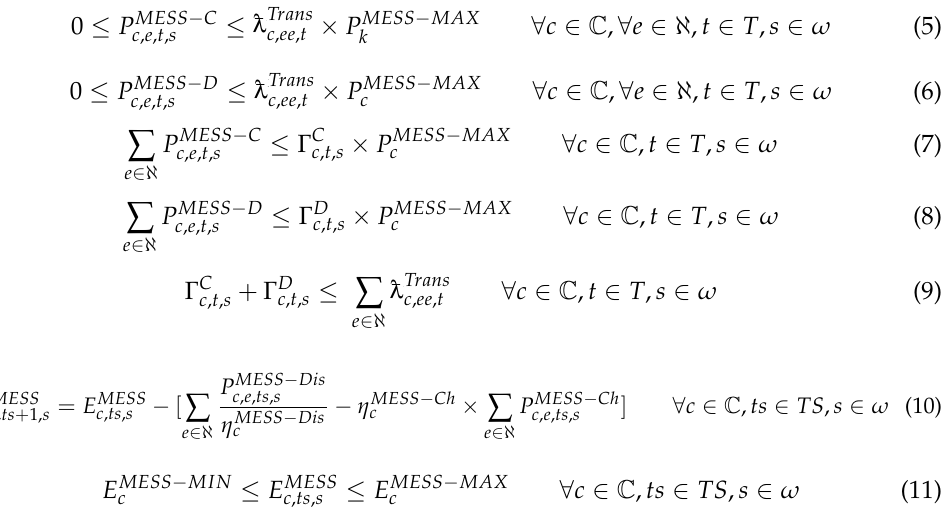
Figure 3. Time ‐ space network (TSN) concept. Equation (1) implies that MESS’s position can be located on any arc in time span ts. In (2), any MESS c at the end of the time span ( ts ) is in MG ( e , ts ) in the TSN, which indi ‐ cates that in the following time span ( ts + 1), MESS k should indeed be in one of the arcs that start from MG ( e , ts ). Specifically, Constraint (3) specifies that the outflow at each station equals the starting state of MESS k in the time span (1). Constraint (4) ensures that TESSs will never be able to perform an instantaneous round trip, meaning MESSs going from one MG to another are not allowed to return to the first MG immediately. When the mobile energy storage units arrive at any MG, the following constraints must be